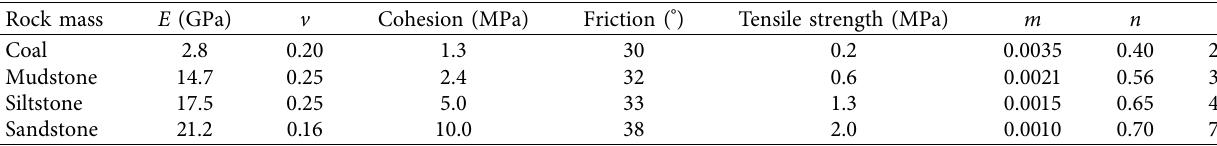
Figure 7: Numerical model including two longwall panels. Table 2: Rock mass properties.